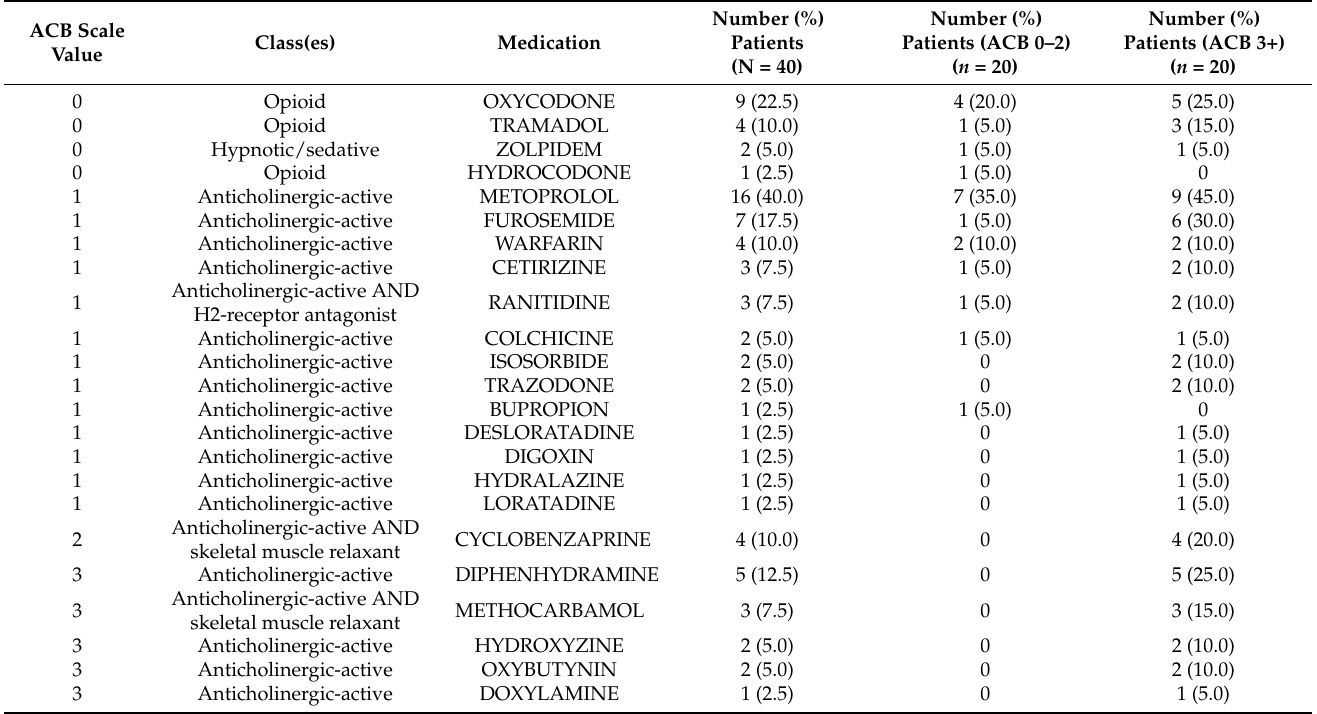
Table 2. Frequency of all prescribed medications, overall and in patients with low vs. high anticholin- ergic